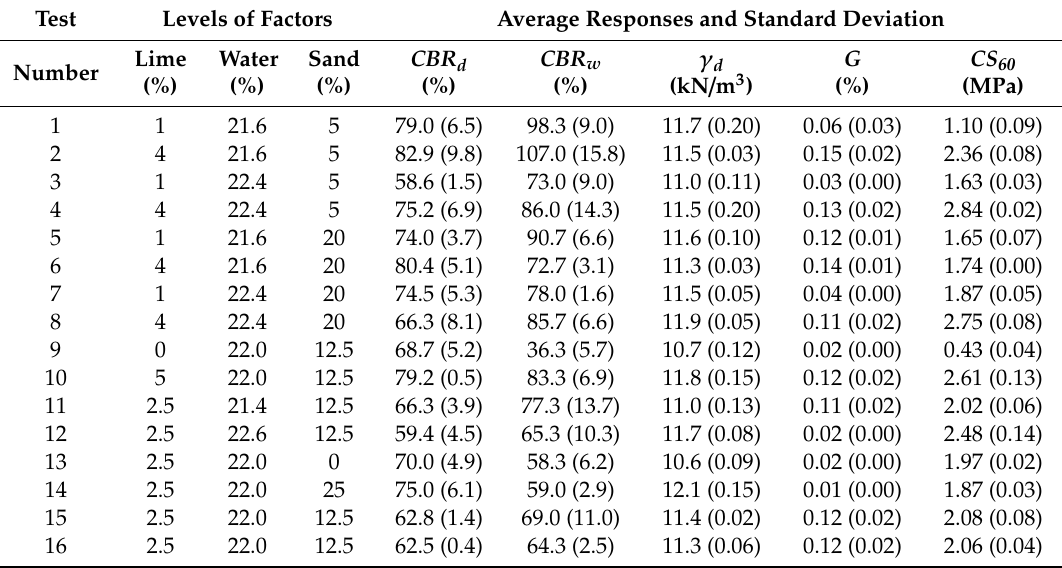
Table 5. Average results of tests carried out on treated